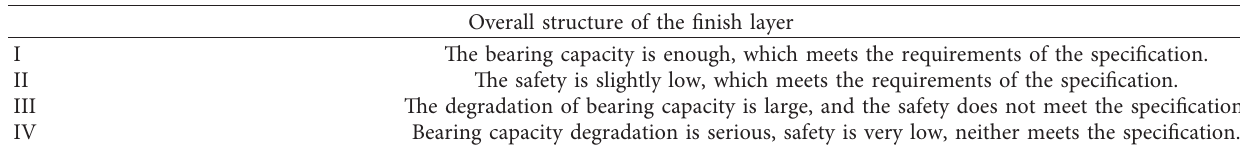
Table 11: Safety classification of the finish layer.